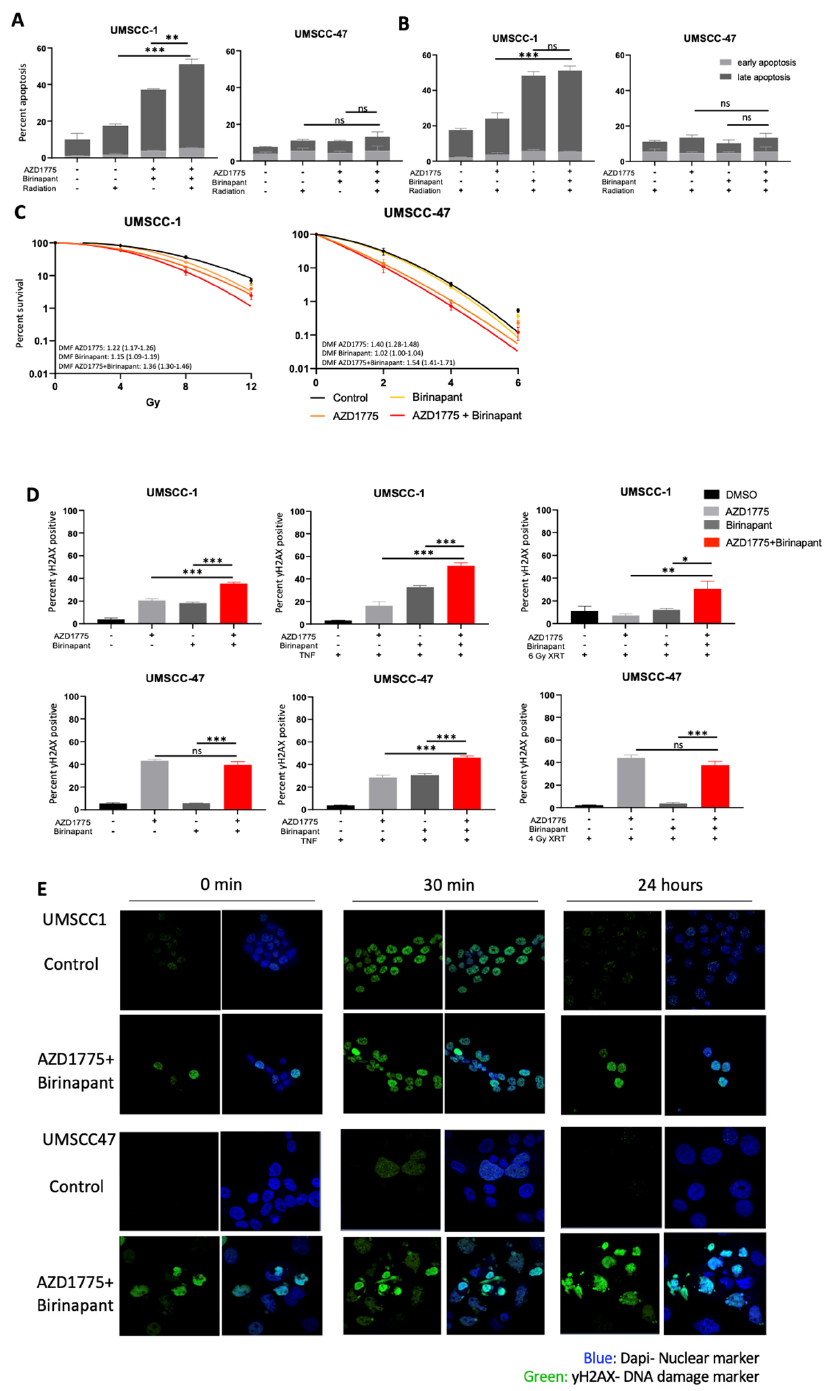
Figure 4. Combination treatment radiosensitizes HNSCC cells via the induction of sustained DNA damage. ( A ) Annexin apoptosis assay at 24 post single-dose radiation with post radiation with a 1 h pretreatment of AZD1775/Birinapant; XRT = 4 Gy for UMSCC ‐ 47 and 6 Gy for UMSCC1.